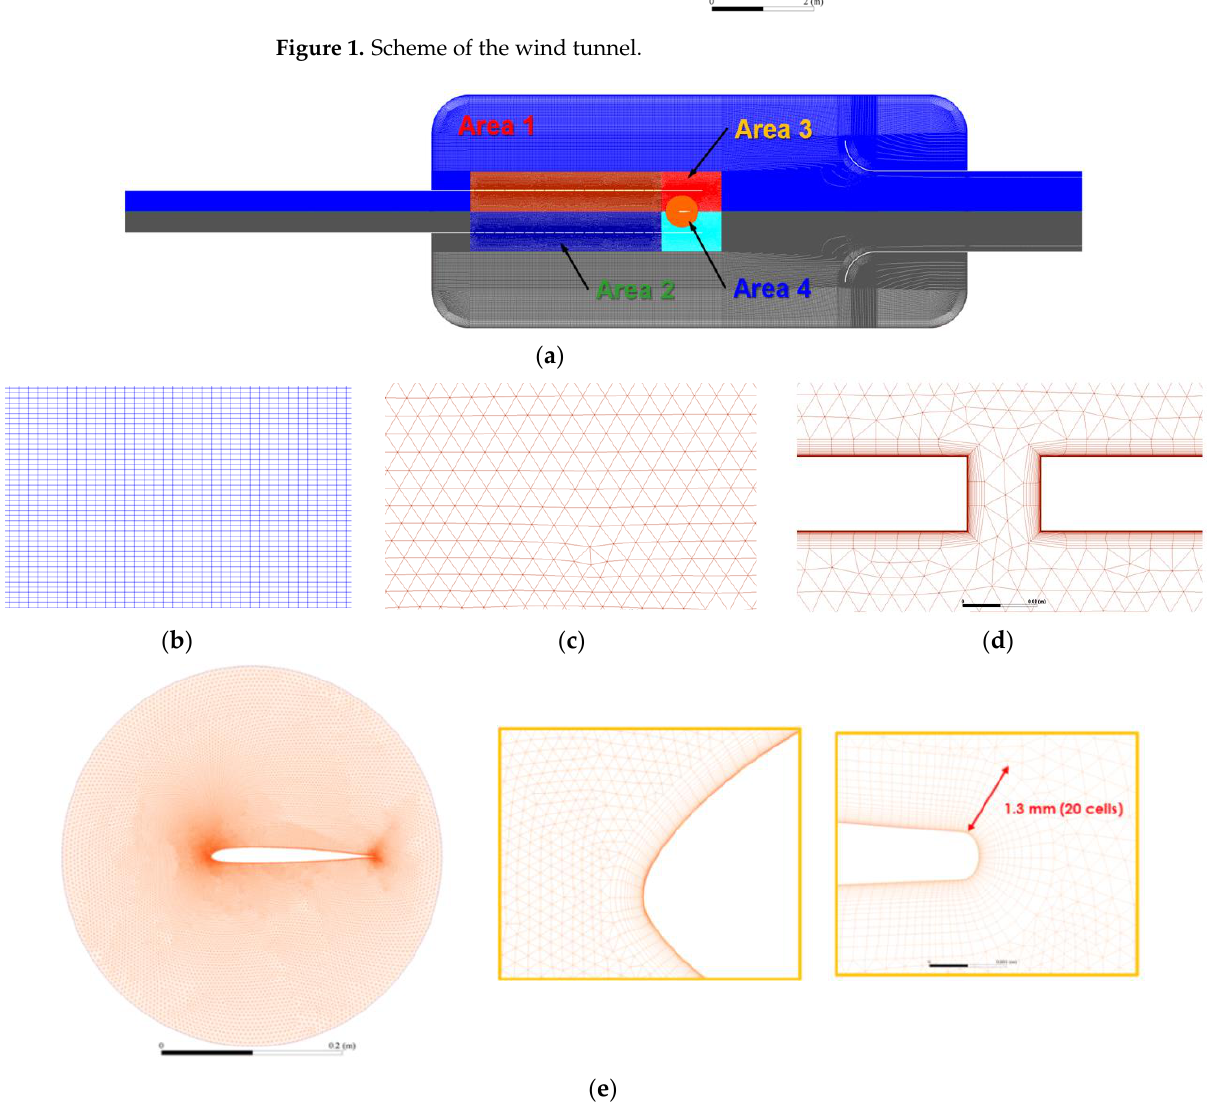
Figure 2. Computational mesh of the WT 2D CFD model: ( a ) overall computational mesh; ( b ) struc- tured mesh (Area 1); ( c ) unstructured mesh (Areas 2, 3, 4); ( d ) perforation zone mesh (Area 2); ( e ) airfoil zone mesh (Area